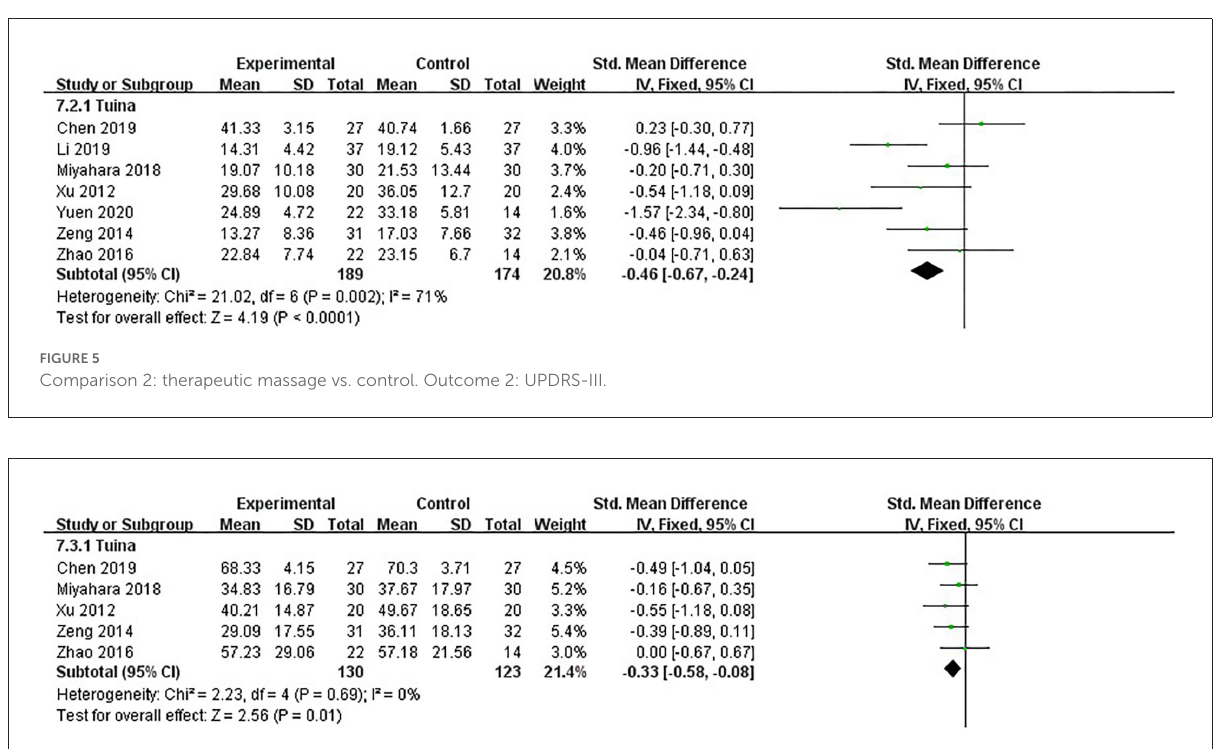
FIGURE6 Comparison 3: therapeutic massage vs. control. Outcome 3: UPDRS-total.